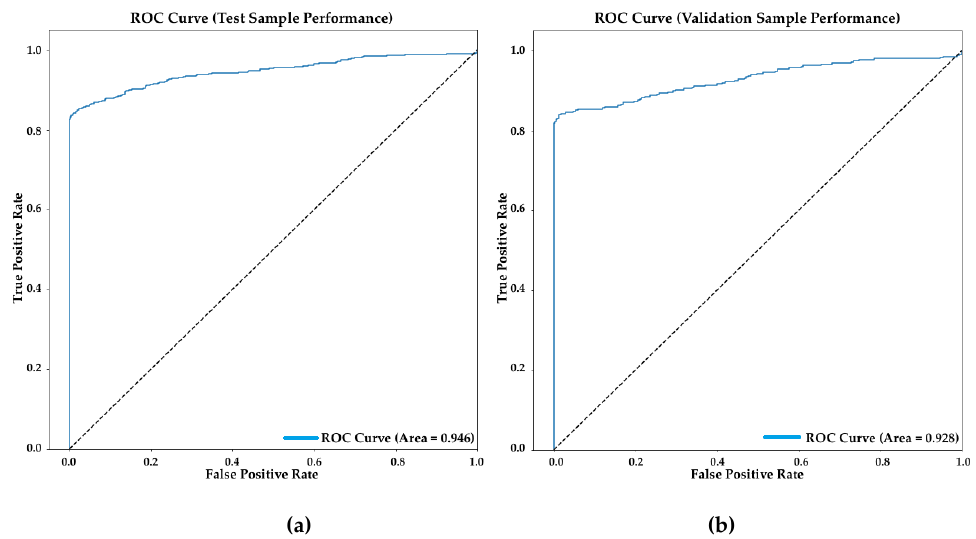
Figure 7. AUC 0.5 cut-off value. ( a ) Test sample performance. ( b ) Validation sample